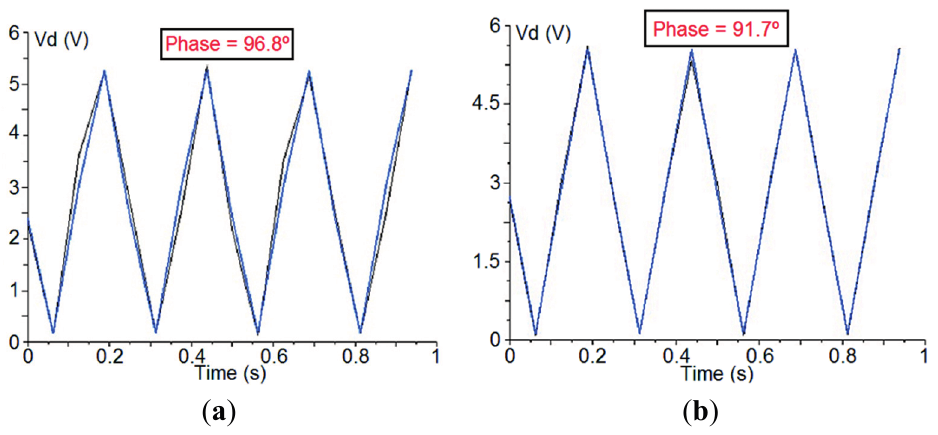
Figure 4. Detected signal before ( a ) and after ( b ) phase-error